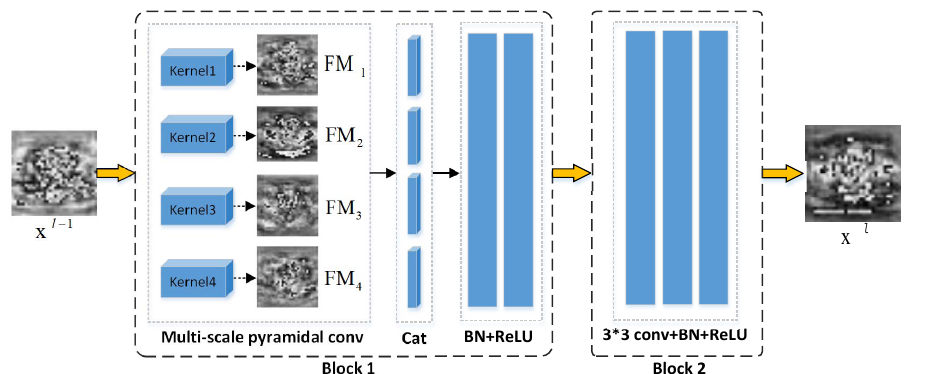
Figure 3. The architecture of the proposed multi-scale encoder with MSPC and traditional convolu- tion